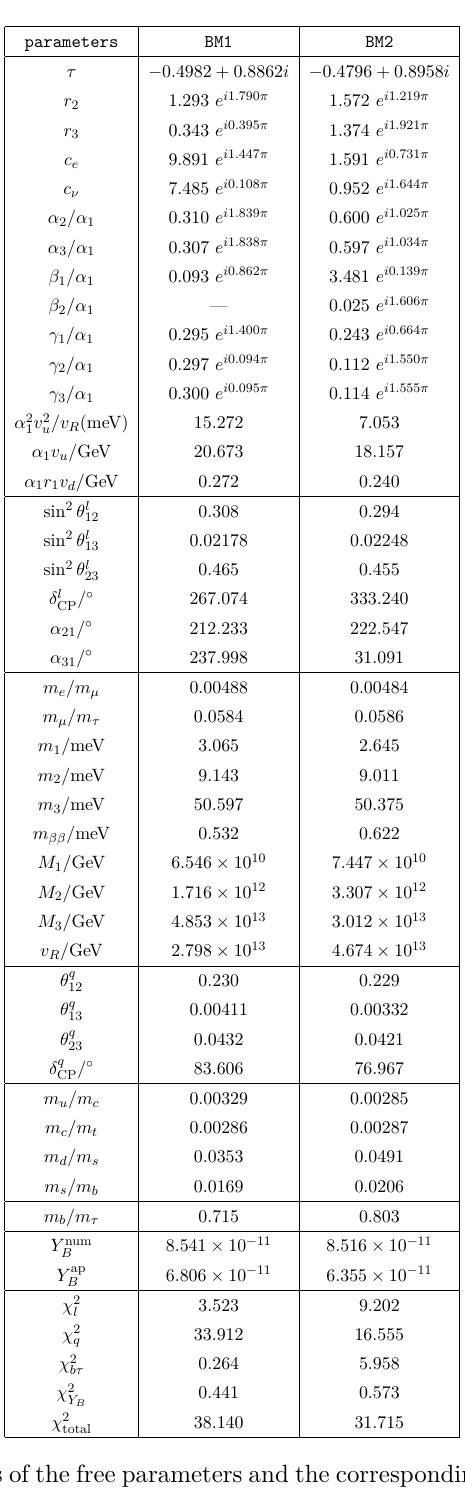
B denotes the result of analytical B